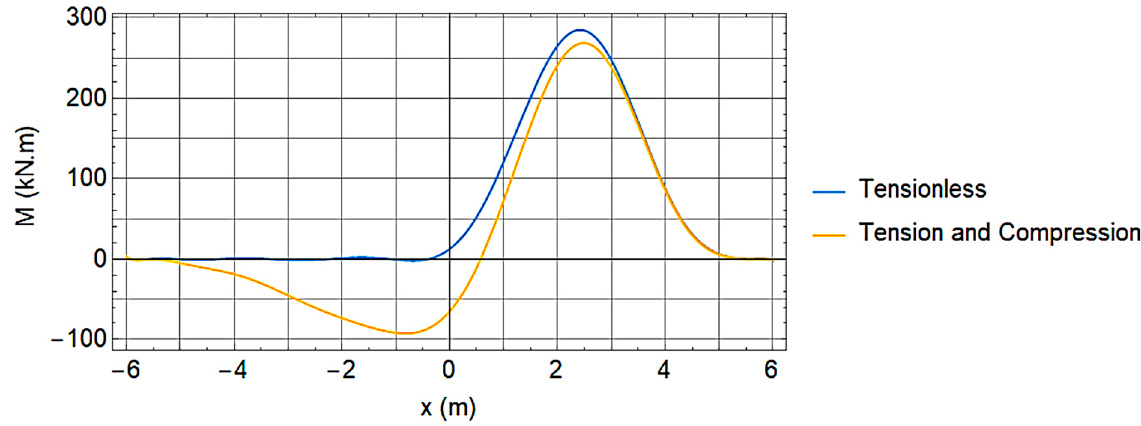
Figure 11. The bending moment diagram for the asymmetric case (X = L/5 ) .